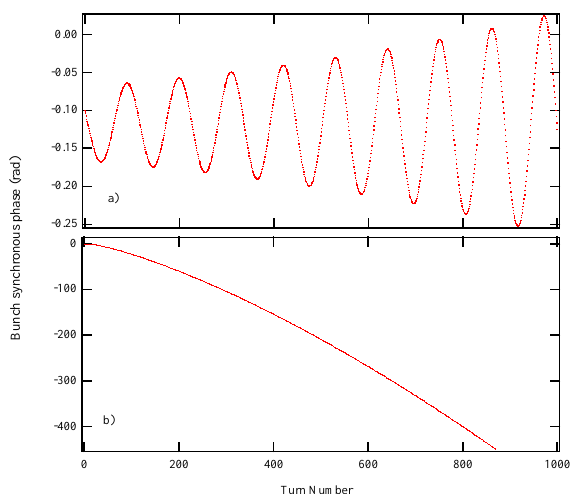
FIG. 7. (Color) Simulation results for a uniform filling with five cavities in case of violation of the (a) ac Robinson stability conditions with cavities tuned to h res (cid:1) 984.3 . (b) dc Robinson stability conditions with cavities tuned to h res (cid:1) 984.05 .